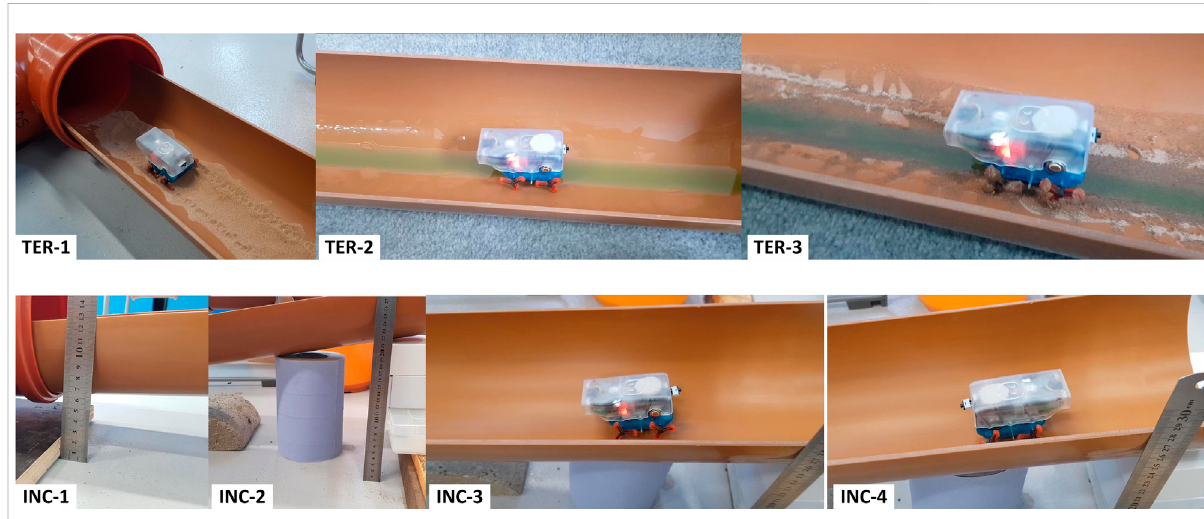
FIGURE 10 SnapshotsoftheJoeyrobotlocomotingacrossdifferentsurfacesandonaninclinedpipe.TER-1showstherobotmovingacrossdrysand.TER- 2andTER-3show therobotmovingalongpipeswithdishwashingliquid,andamixtureofthisliquidandsand. Lowerpanels:Joeyrobotclimbingup (INC-4) and down (INC-3) an inclined pipe section shown in INC-1 and